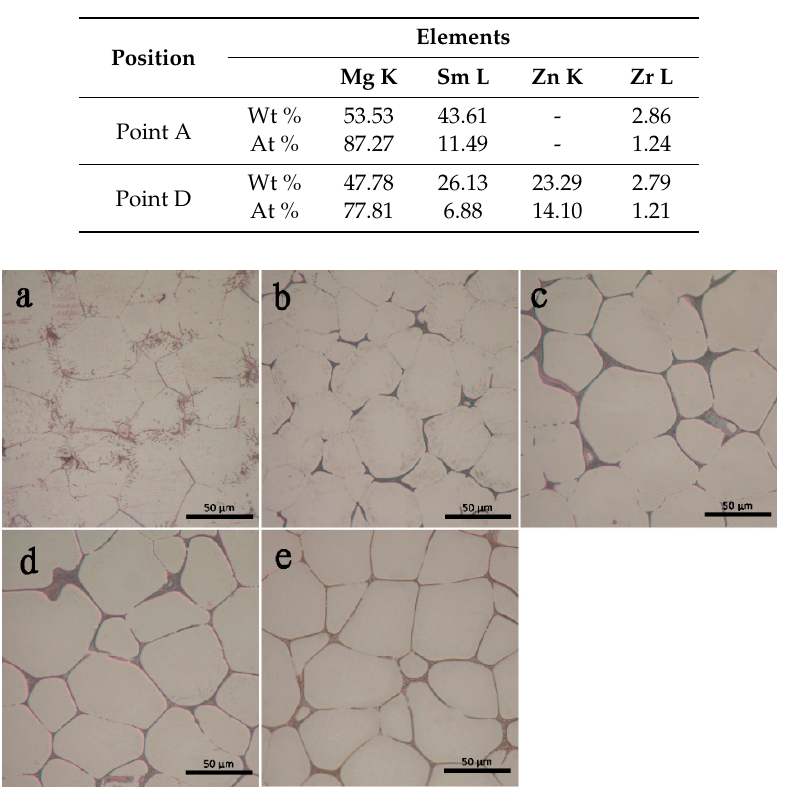
Figure 2. Optical micrographs of as-cast Mg–4Sm– x Zn–0.5Zr alloys: ( a ) x = 0; ( b ) x = 1; ( c ) x = 2; ( d ) x = 3; ( e ) x = 4.